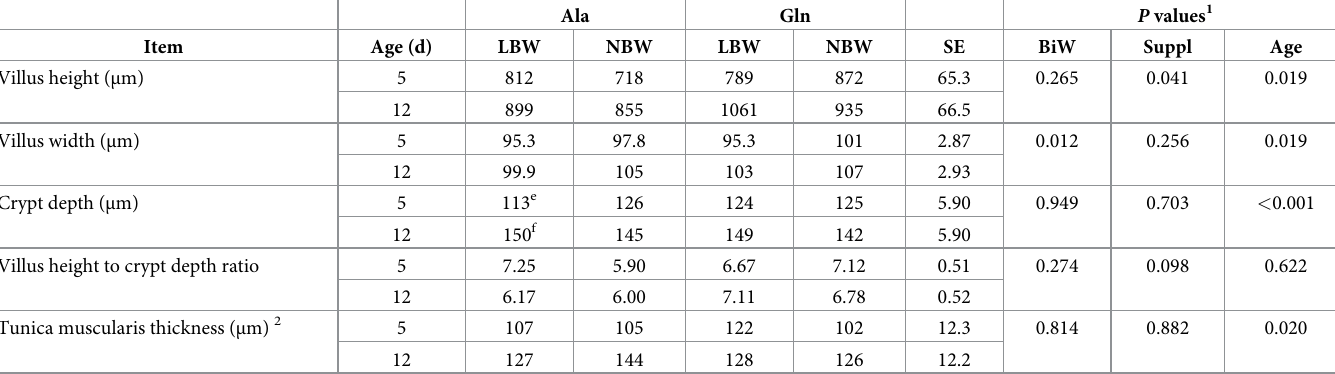
Table 1. Jejunal morphology characteristics in low and normal birth weight male suckling piglets.